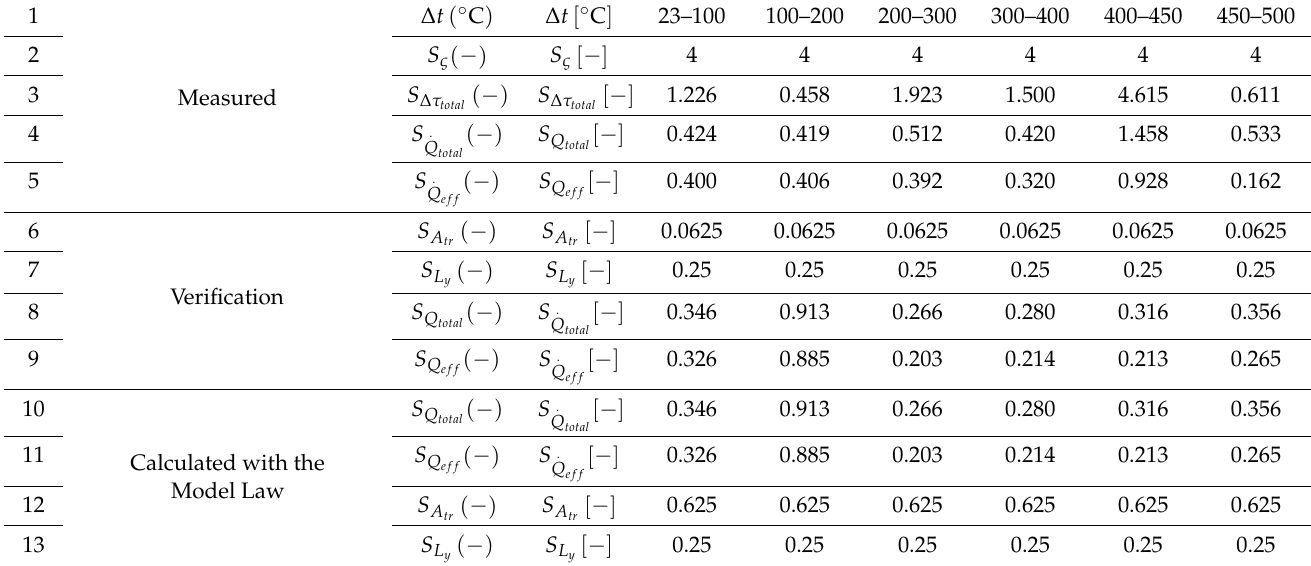
Table A7. The 1:4/1:1 Unpainted